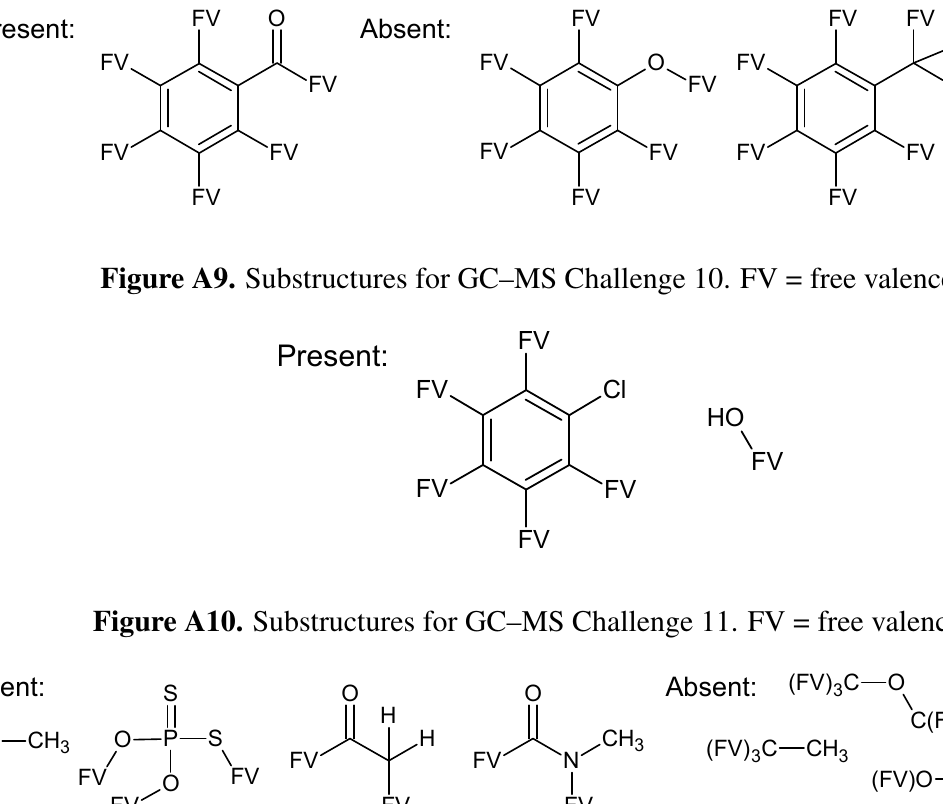
Figure A8. Substructures for GC–MS Challenge 9. FV = free valence.